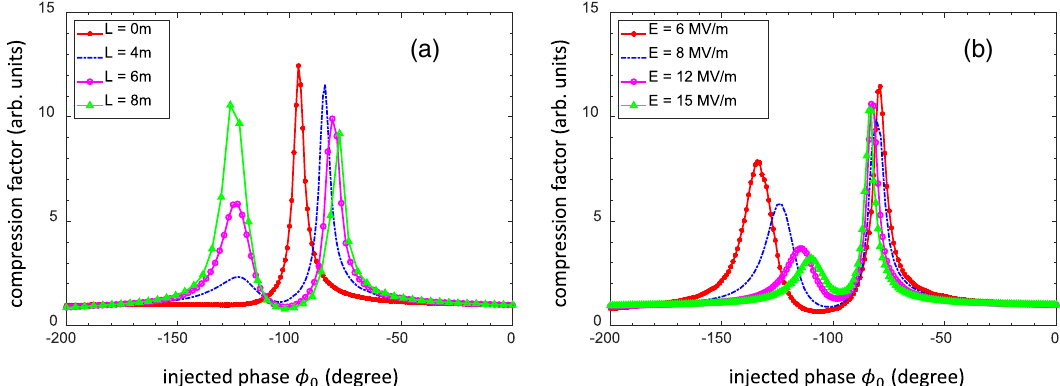
FIG. 3. Effects on the compression factor (a) when the gradient of the TWA tube is fixed at 8 MV = m and the drift length is varied and (b) when the drift length is fixed at 6 m and the gradient of the TWA tube is varied.